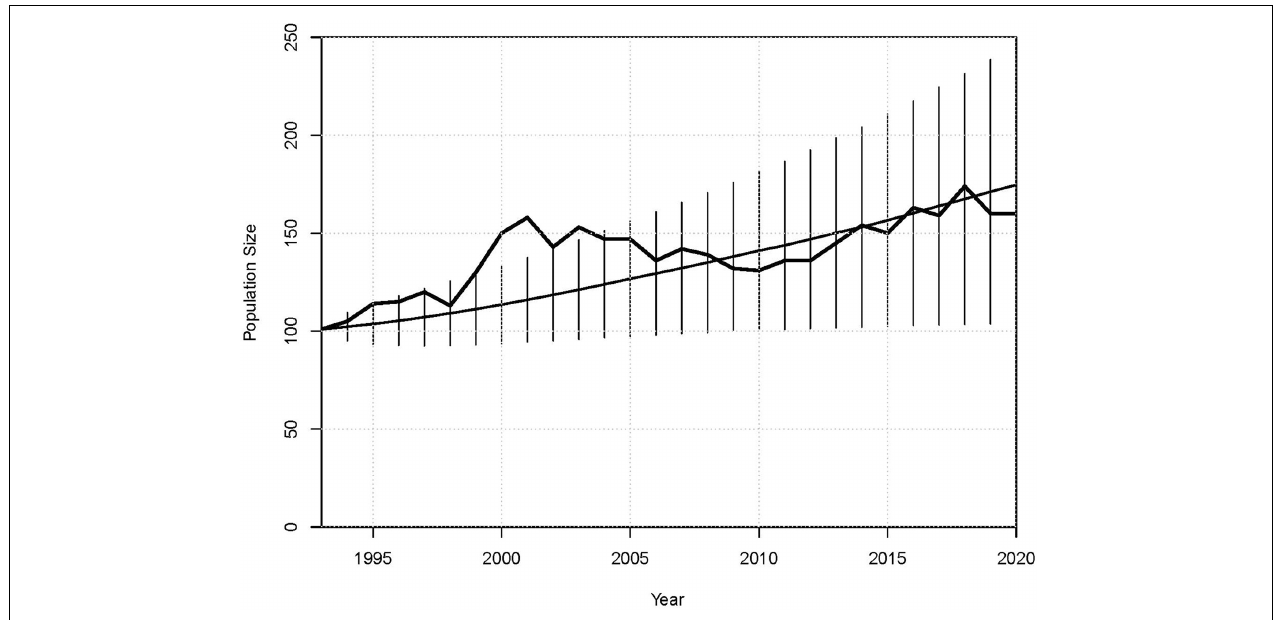
FIGURE 2 | Mean projected population sizes from 1993 to 2020, with error bars showing the approximate 95% of the distribution of N across 10,000 iterations, and observed size of the Sarasota Bay population (heavier line) as of the start of each year.